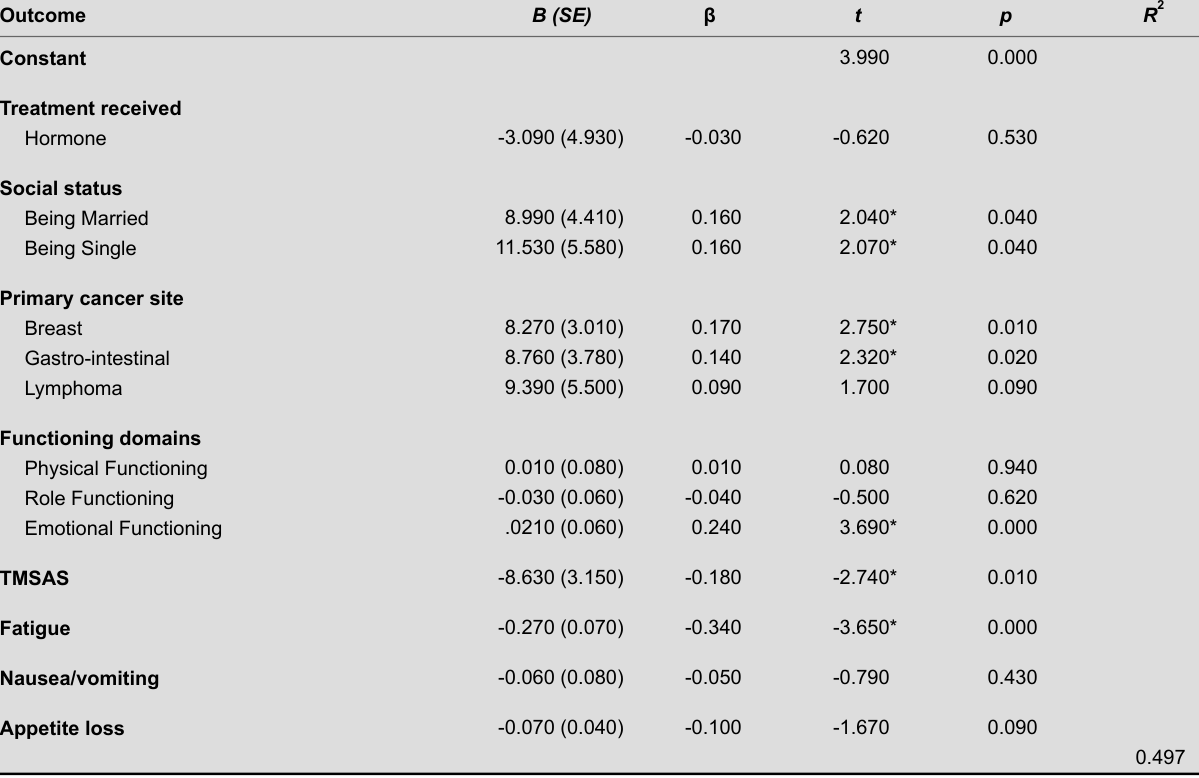
Final Model for Predictors of Quality of